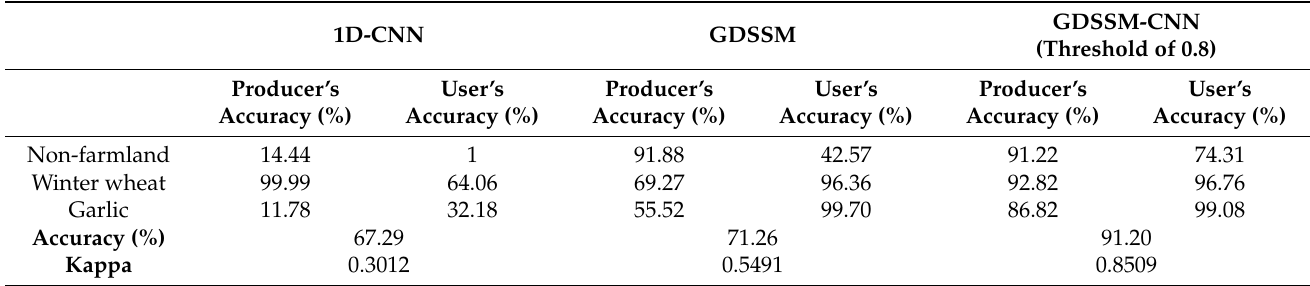
Table 2. Accuracy evaluation for different classifiers. Figure 8. Confusion matrices for models generated by different classifiers. ( a ) 1D-CNN; ( b ) GDSSM; ( c ) GDSSM-CNN.